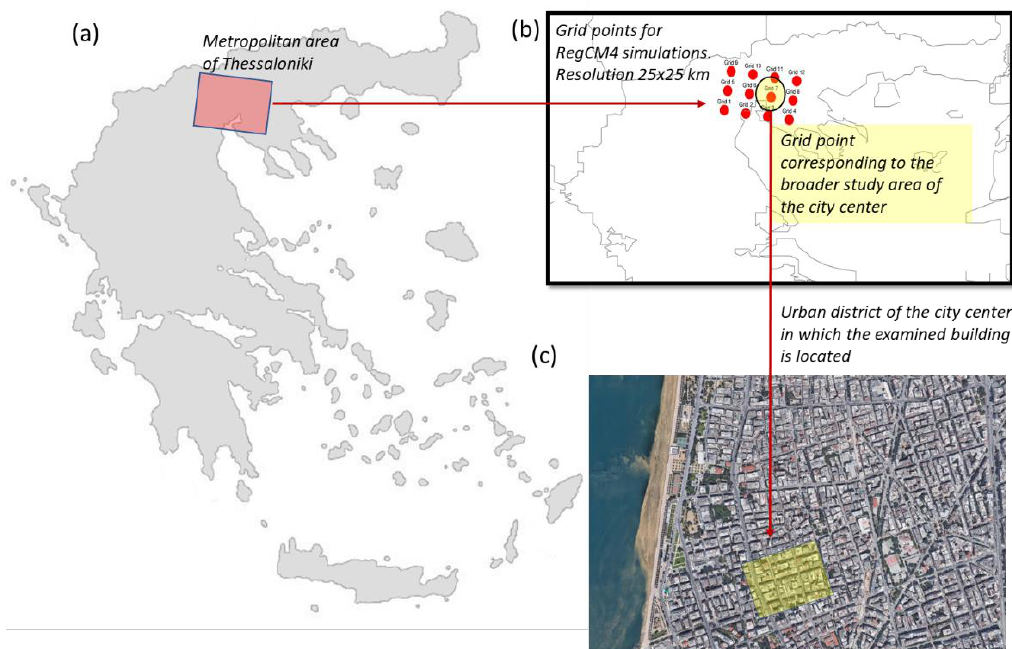
Figure 2. ( a ) Location of Thessaloniki in the map of Greece, ( b ) grid points applied to the RegCM4 simulation run with a spatial resolution of 25 × 25 km and ( c ) correspondence of the examined case study area to a broader area, covered by a grid point of the regional climate model.